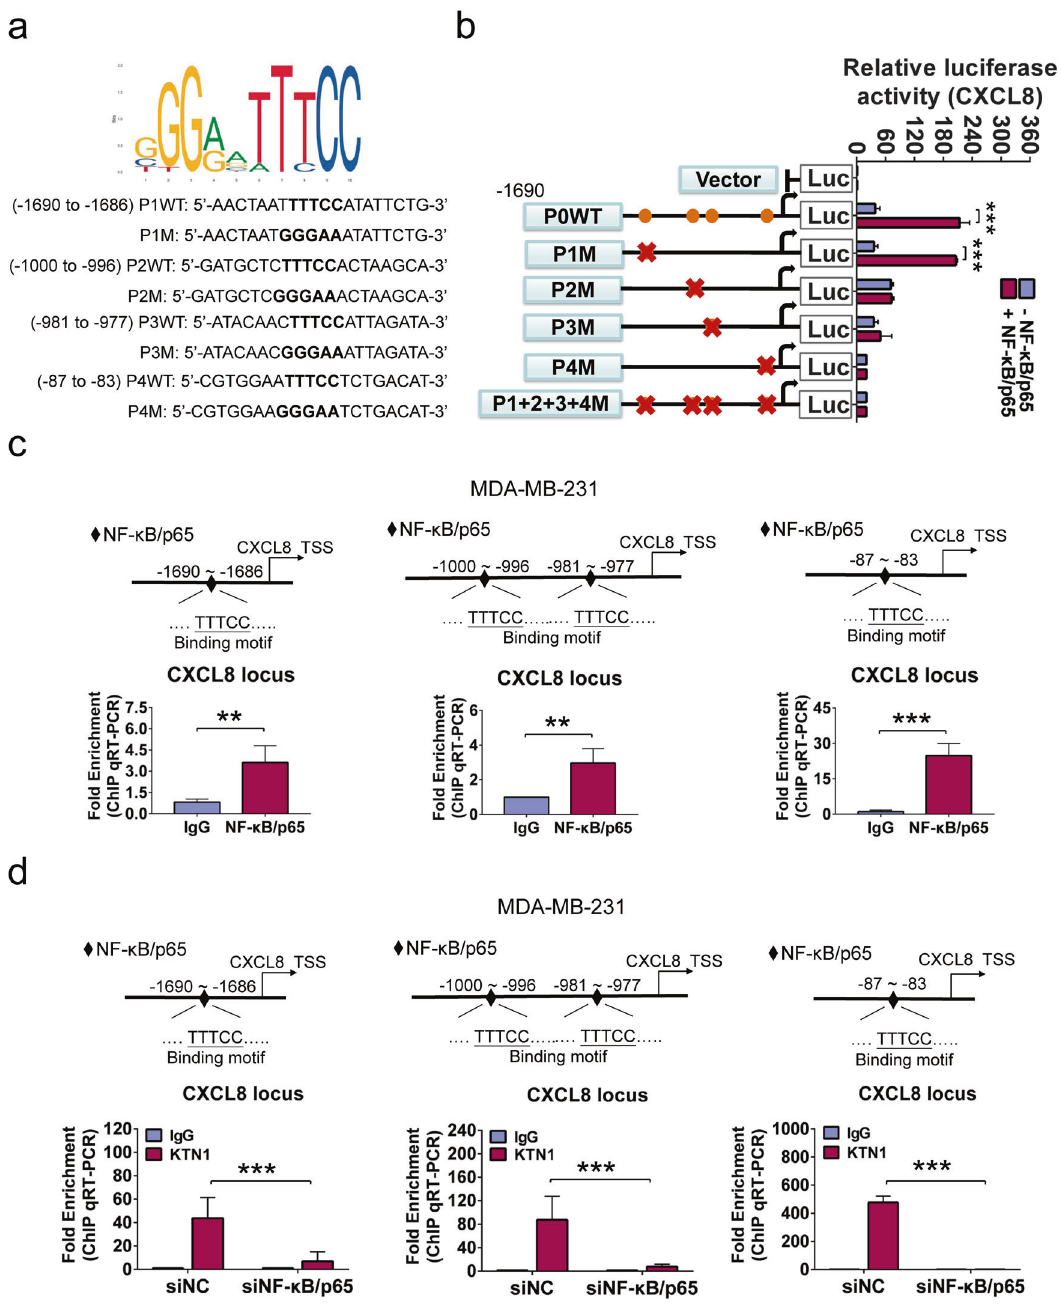
Fig. 5 NF- κ B/p65 bound the CXCL8 gene to enhance its promoter activity. a Predicted binding sites through UCSC genome browser (http:// genome.ucsc.edu/) and JASPAR database (http://jaspardev.genereg.net). b Luciferase activity of CXCL8 gene promoter reporters in 293 T cells transfected with wild type NF- κ B/p65 plasmid or mutant NF- κ B/p65 plasmid. Orange circles showed the position of the putative NF- κ B/p65- binding sites, and the red “ × ” showed the mutated NF- κ B/p65-binding sites. P, putative binding site; M, mutant; WT, wild type. c ChIP analysis of NF- κ B/p65 enrichment on promoters of CXCL8 gene in MDA-MB-231 cells. IgG mouse, immunoglobulin G mouse. The different regions containing different putative NF- κ B/p65-binding sites from left to right. d The binding enrichment of KTN1 at the above binding sites on the promoter regions detected after knockdown of NF- κ B/p65. Data shown are mean ± SD of triplicate measurements that have been repeated 3 times with similar results. Data were analyzed using two-tailed Student ’ s t-test, One-Way ANOVA and Dunnett ’ s multiple comparison test (* P < 0.05, ** P < 0.01, *** P <